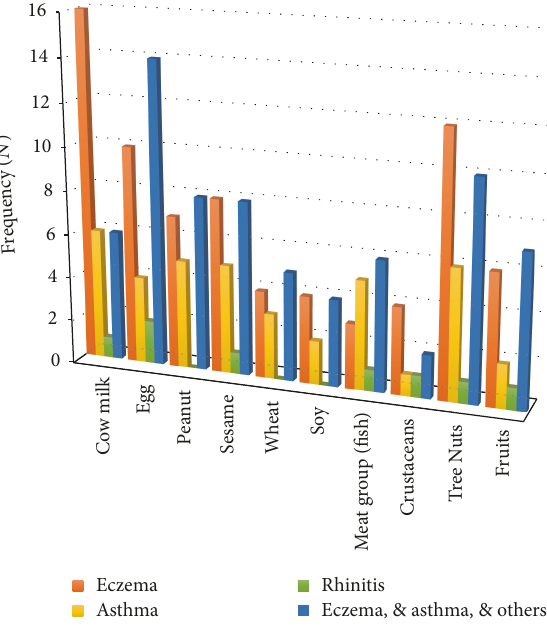
Figure 3: The most common food allergens in children with confirmed food allergy, stratified by type of atopic